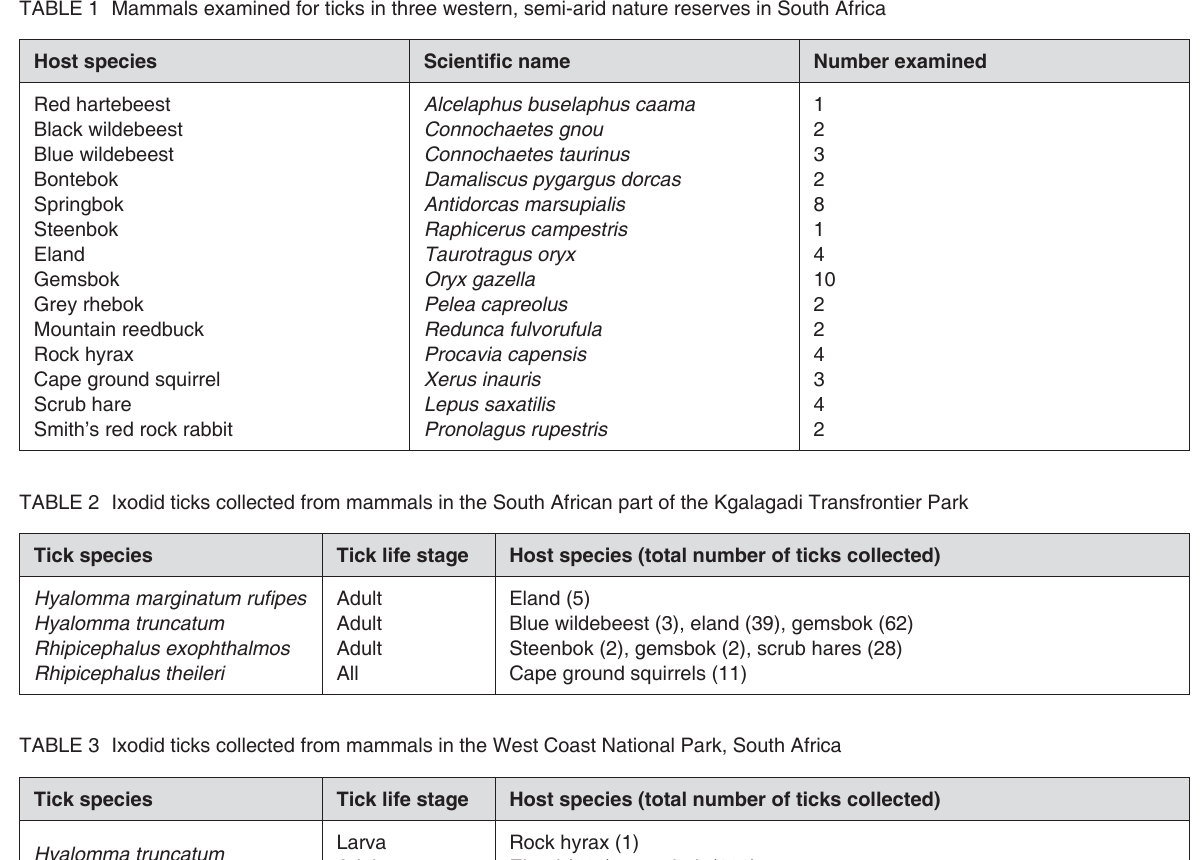
TABLE 1 Mammals examined for ticks in three western, semi-arid nature reserves in South Africa